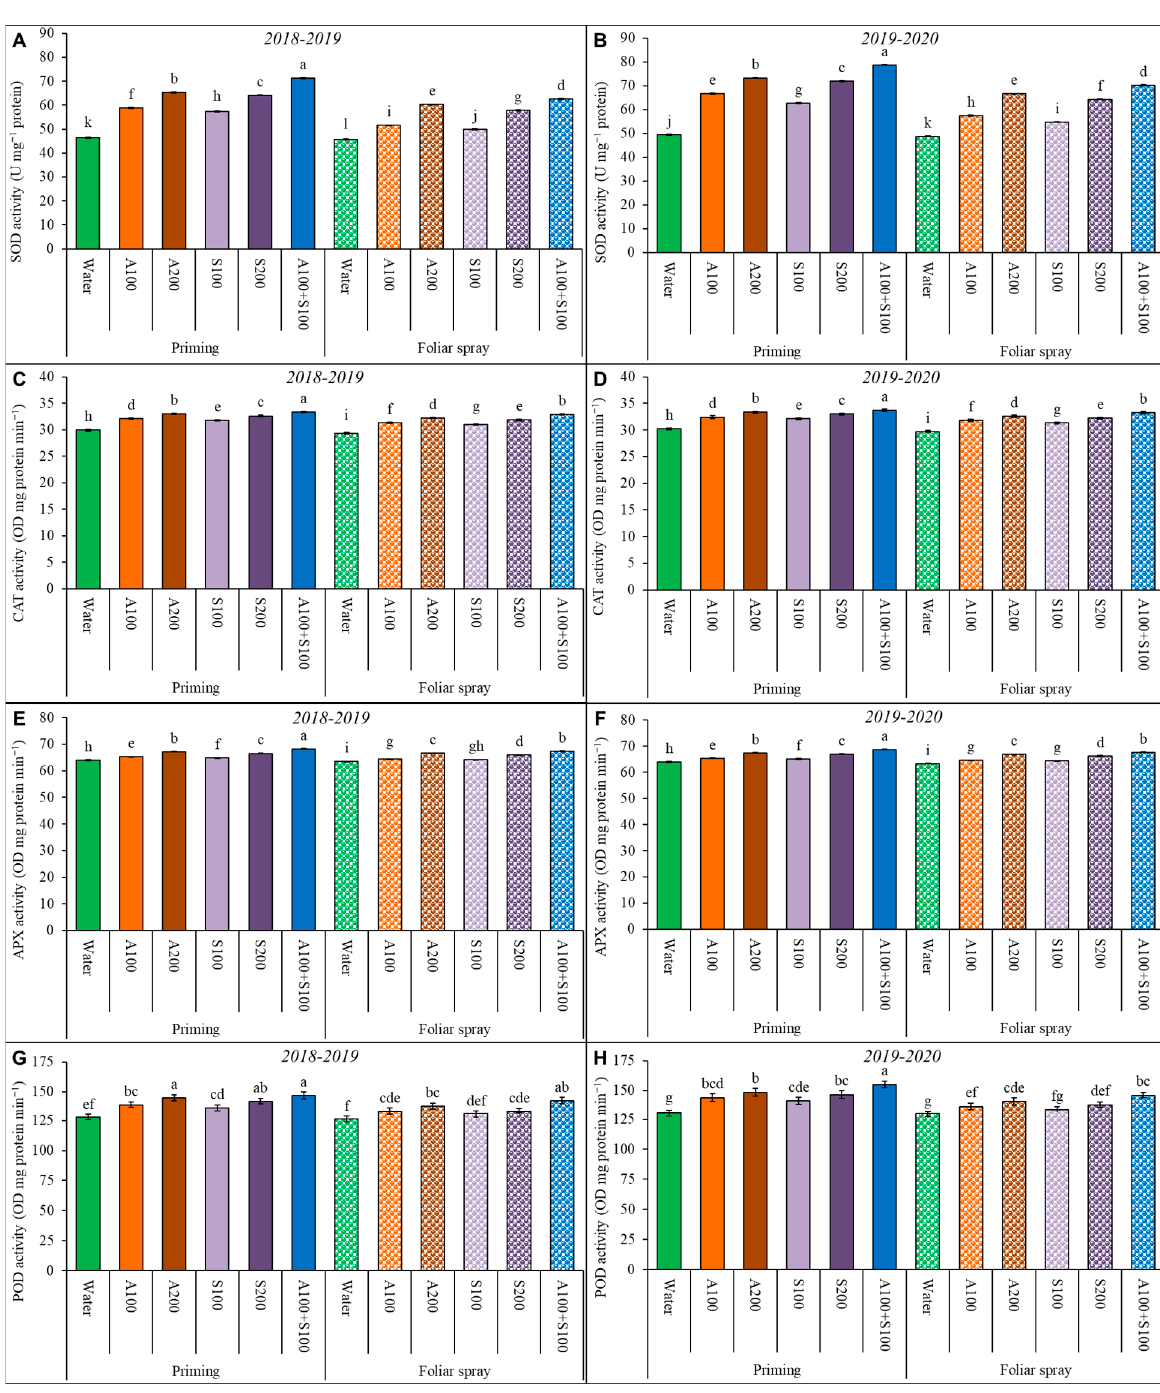
Figure 3. Antioxidant enzyme activities affected by AA and SA treatments in wheat leaves at 80 DAS during the two winter seasons 2018/2019 and 2019/2020. ( A , B ): SOD, ( C , D ): CAT, ( E , F ): APX, ( G , H ): POD. Data are mean ± standard error ( n = 4). Letters represent significant differences between treatments at p < 0.05 level according to LSD test.